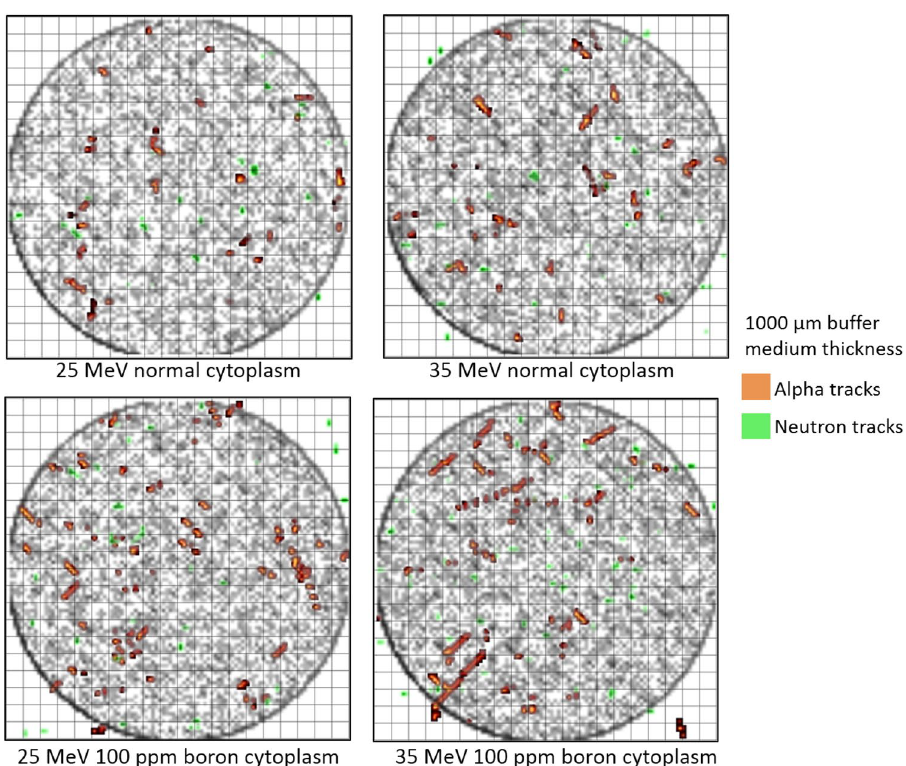
Figure 5. The tracks of alpha particles, neutrons and incident protons (shown in black) generated as a result of 25 and 35 MeV irradiation of cell array with buffer medium thickness of 1000